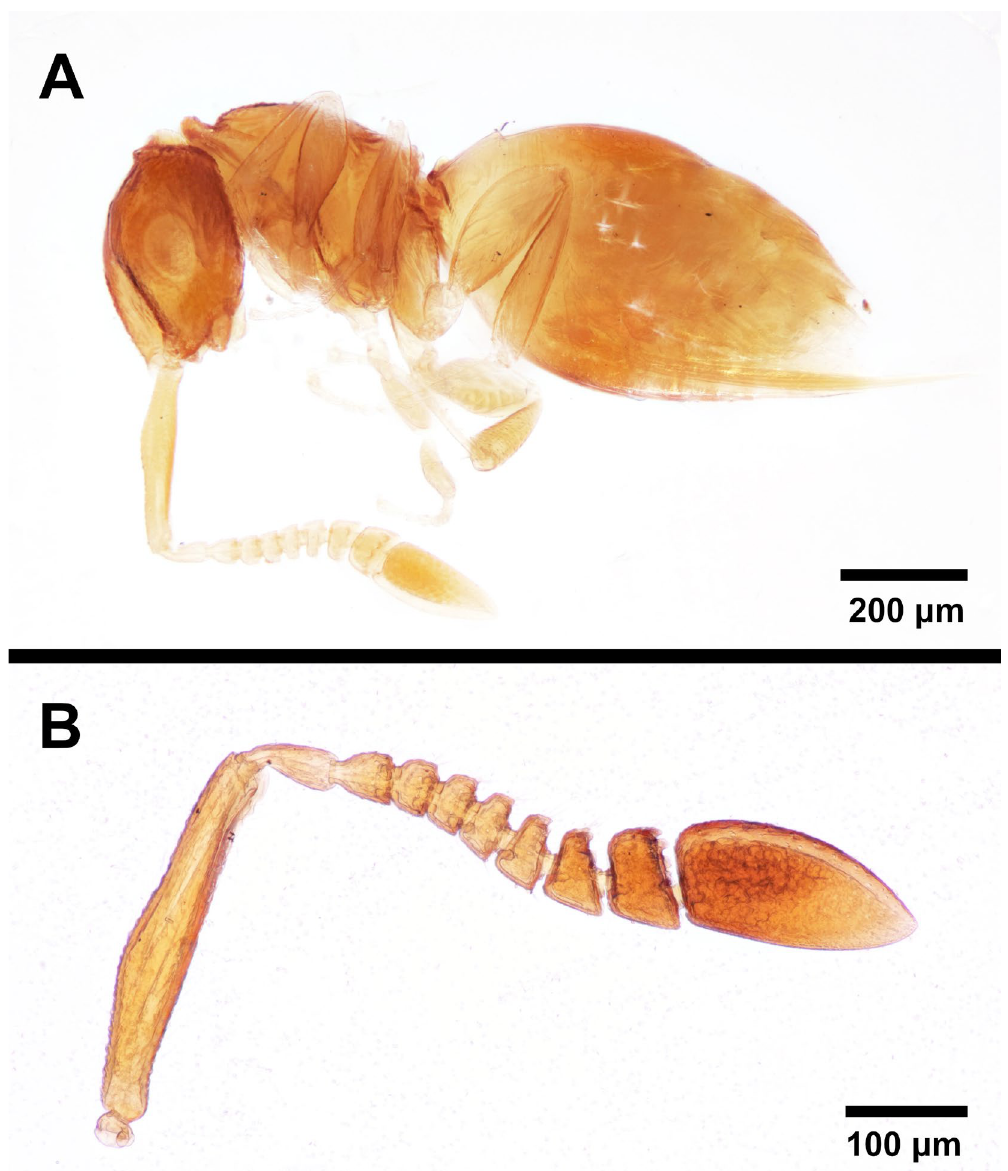
Fig. 12. Ceraphron crenulatus kieffer, 1913, holotype, ♀. A . Lateral view (MNhN EY25351). B . right antennae (MNhN